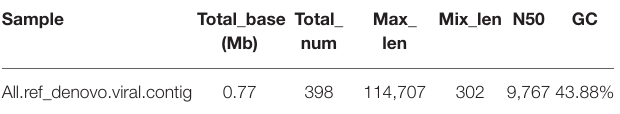
TABLE 7 | Virus contig statistics.